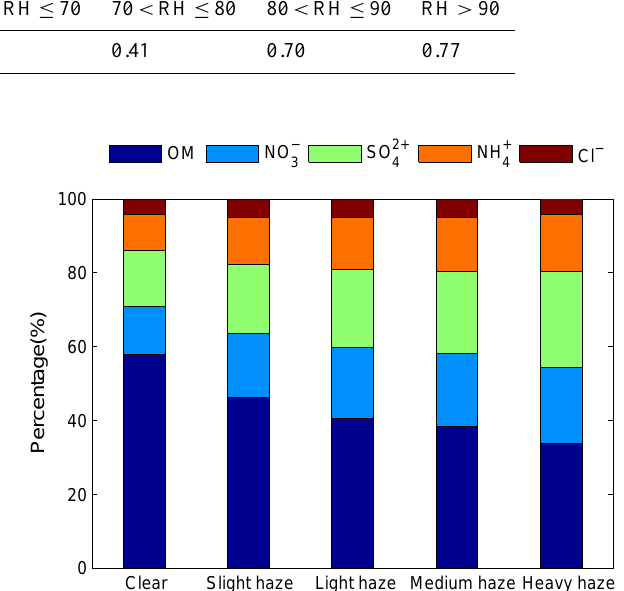
Figure 13. Correlation between the MLH and visibility according to RH in Beijing. Figure 14. Mass percentage of OM, NO